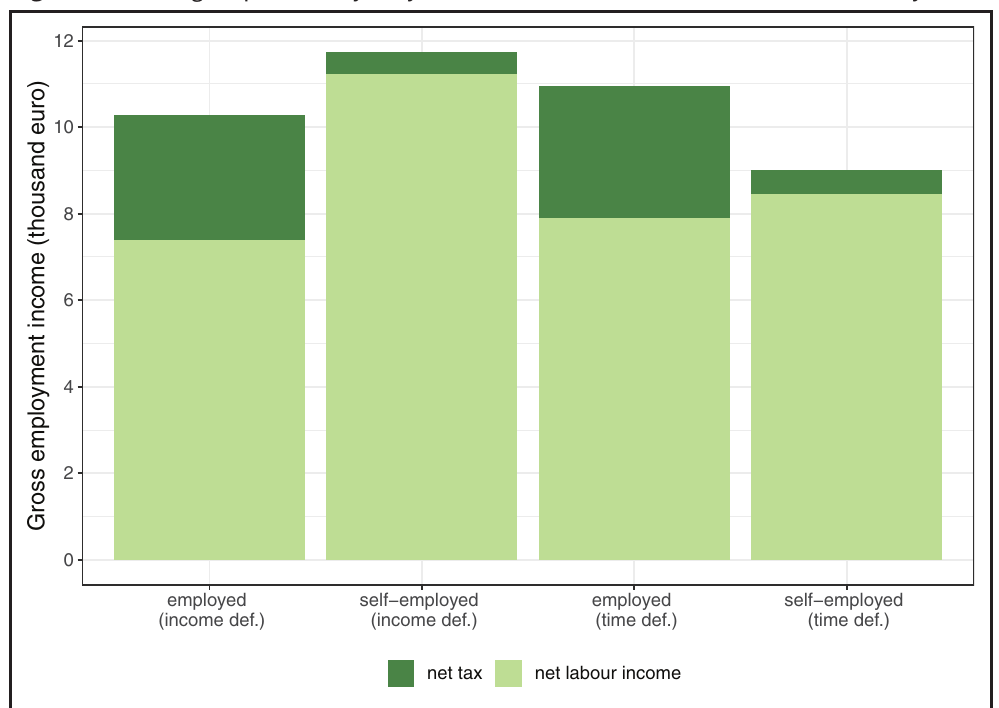
Average equivalized yearly income in Lithuania for 2014–2015 reference